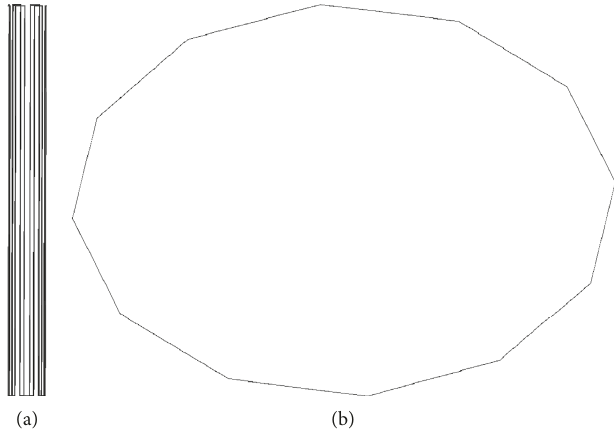
Figure 18: Simulation model of the folded hoop deployment: (a) status 1; (b) status